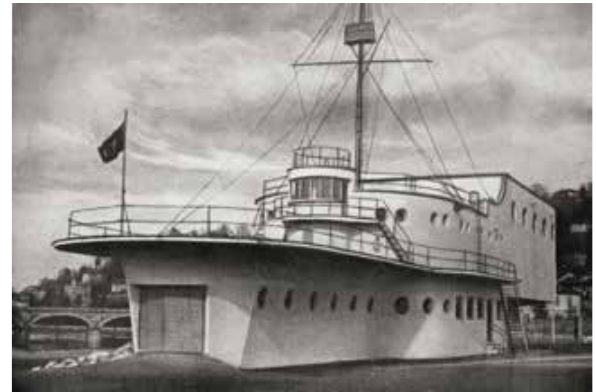
Figure 2. Archival drawing of the 'Casa del Marinaretto'.